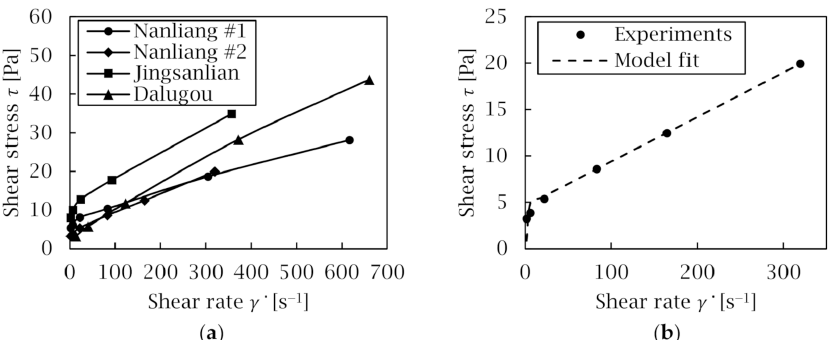
Figure 5. Experiments data and the model fit of the crude oil viscosity. ( a ) Experiments data of the crude oils: shear stress vs. shear rate relation [15]. ( b ) Bingham model fit of one typical crude oil viscosity experiment data from ( a ).